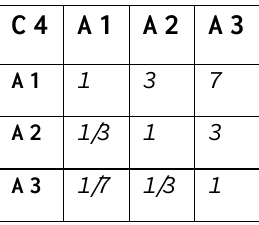
Table 4.6 Matrix M5: comparison of alternatives by the ratio of preference with respect to the criterion